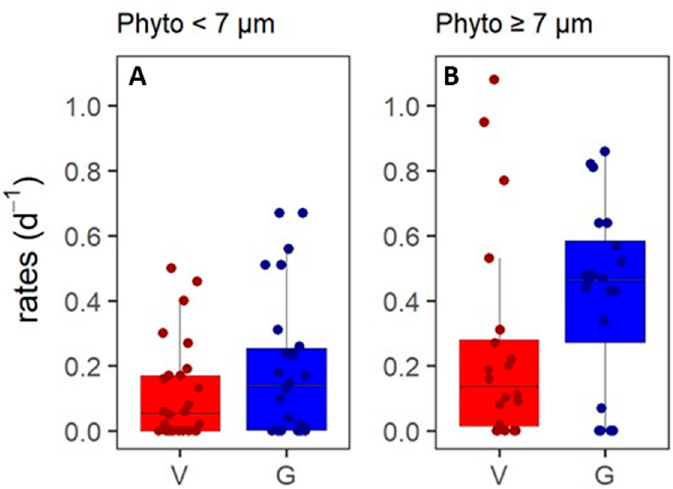
Figure 4. Viral lysis (V) and microzooplankton grazing (G) of phytoplankton for different size ranges. ( A ) Phytoplankton <7 µm ( n = 26). ( B ) Phytoplankton ≥ 7 µm ( n = 20). The black line shows the median, the boxes show the interquartile range (IQR), and the whiskers show minimum and maximum values without outliers. Outliers are defined as outside 1.5 × IQR. The colored dots show the data